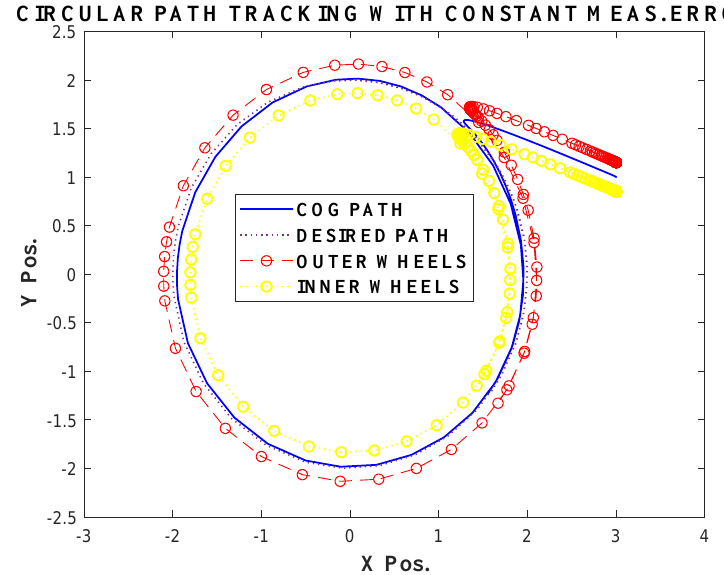
Figure 6. Circular path tracking with slow varying measurement.